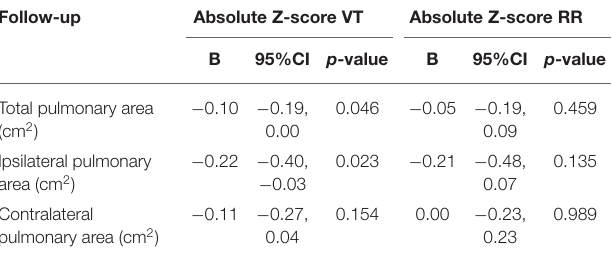
TABLE 2 | Linear regression analysis between radiographic measurements and absolute Z-Score Tidal Volume (V T ) or absolute Z-Score Respiratory Rate (RR) in the follow-up population ( n = 43).